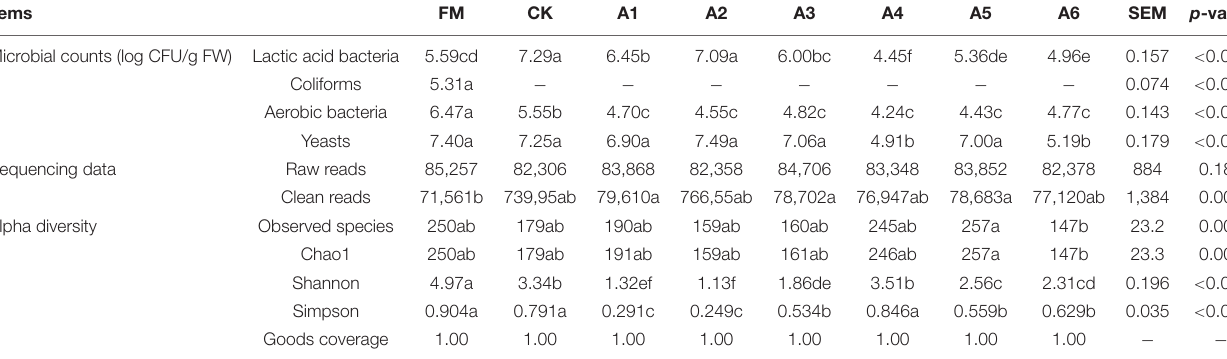
TABLE 3 | Microbial counts, sequencing data, and alpha diversity of bacteria in alfalfa silages ( n = 4).